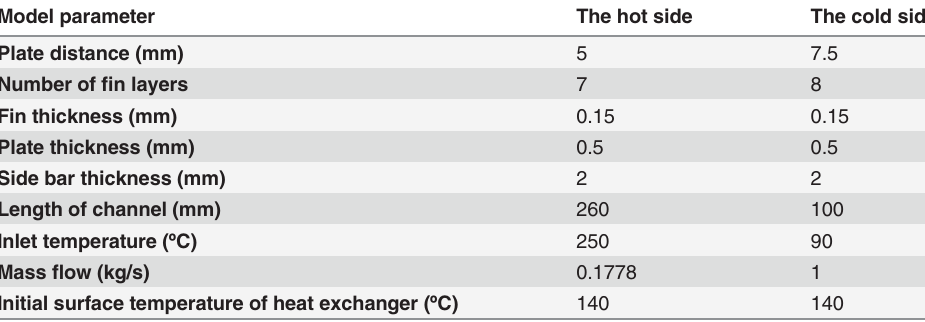
Table 2. Model parameters of the heat exchanger. Model